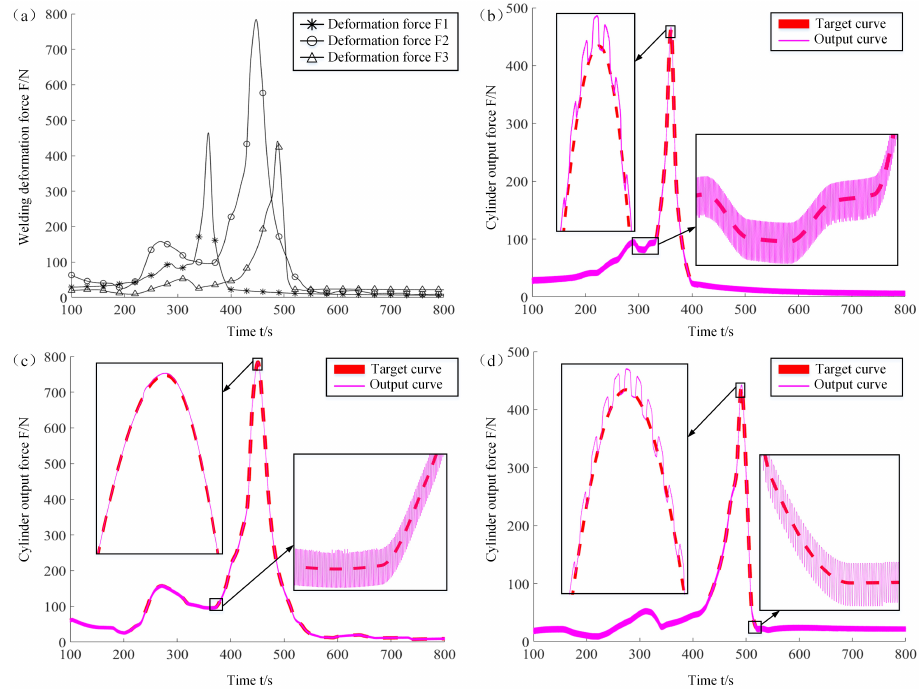
Figure 14 Figure 14. Experimental results:( a ) the target curves of three limited locations; ( b ) the output curve when the input target curve is F1; ( c ) the output curve when the input target curve is F2; ( d ) the output curve when the input target curve is